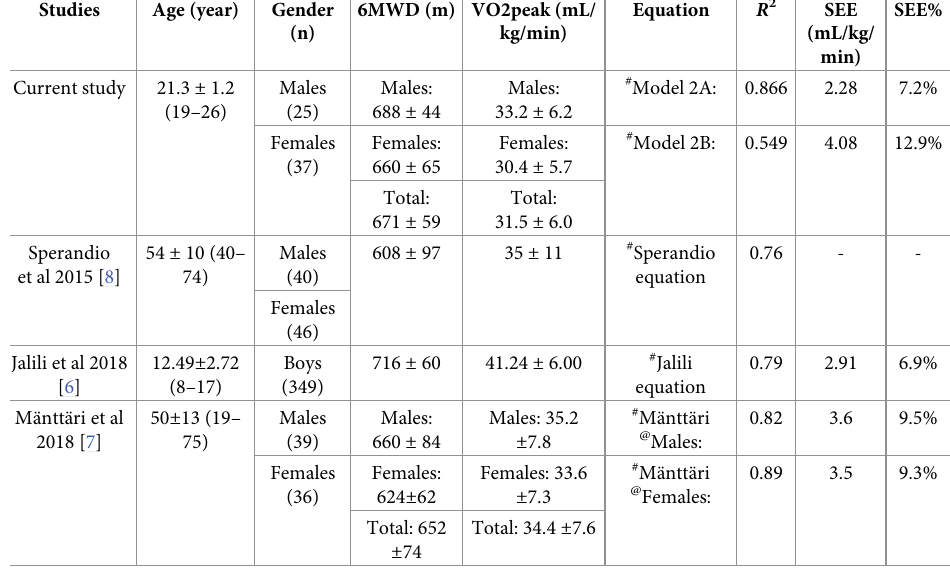
Table 6. VO 2peak prediction equations using 6-minute walk distance (6MWD) as predictor variable.